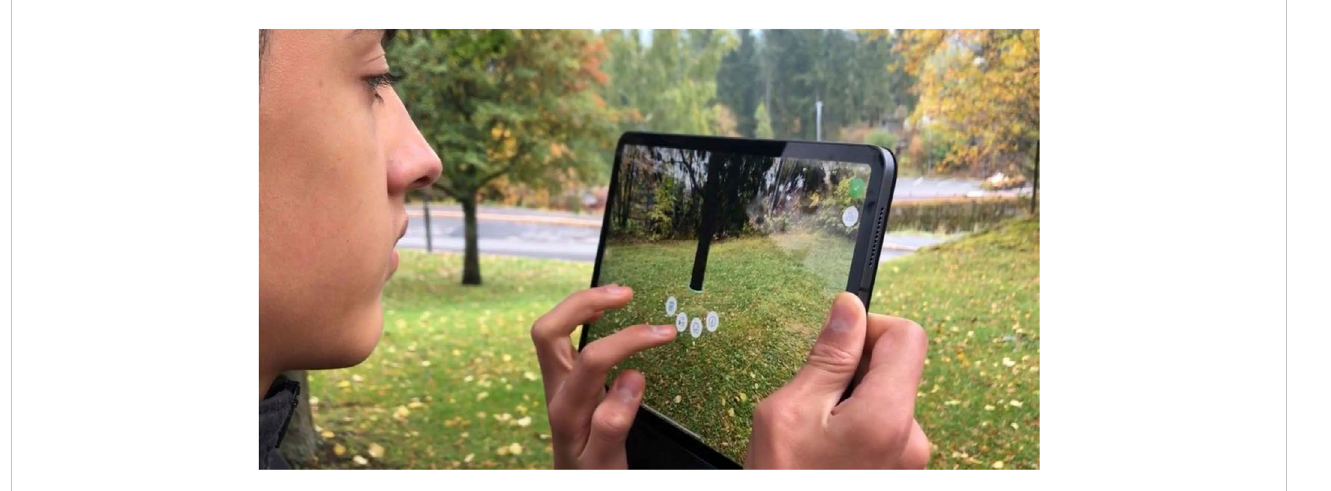
FIGURE 10 Image depicting youth user during